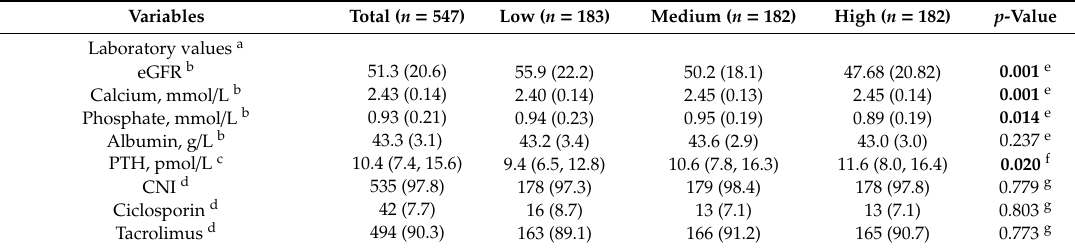
Table 2. One-year post-transplant